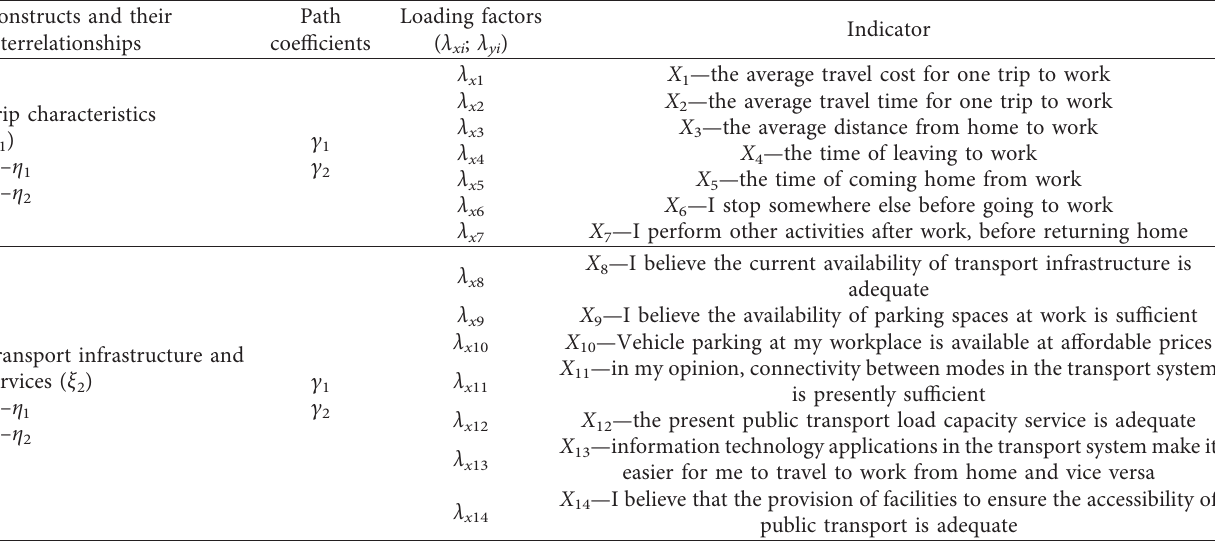
Table 2: Description of measurement items in the model and indicators to measure the latent